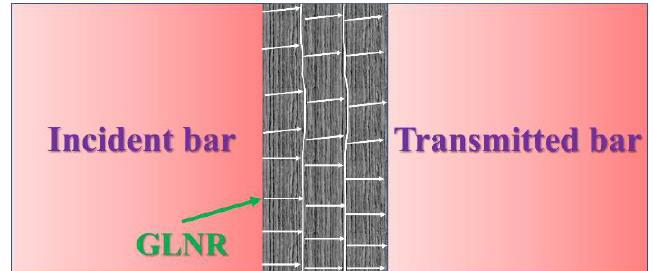
Figure 1. Loading scheme showing the impact of an incident bar onto specimen causing shock wave front generation and resulting deformation in graphene-like nanoribbons (GLNRs).